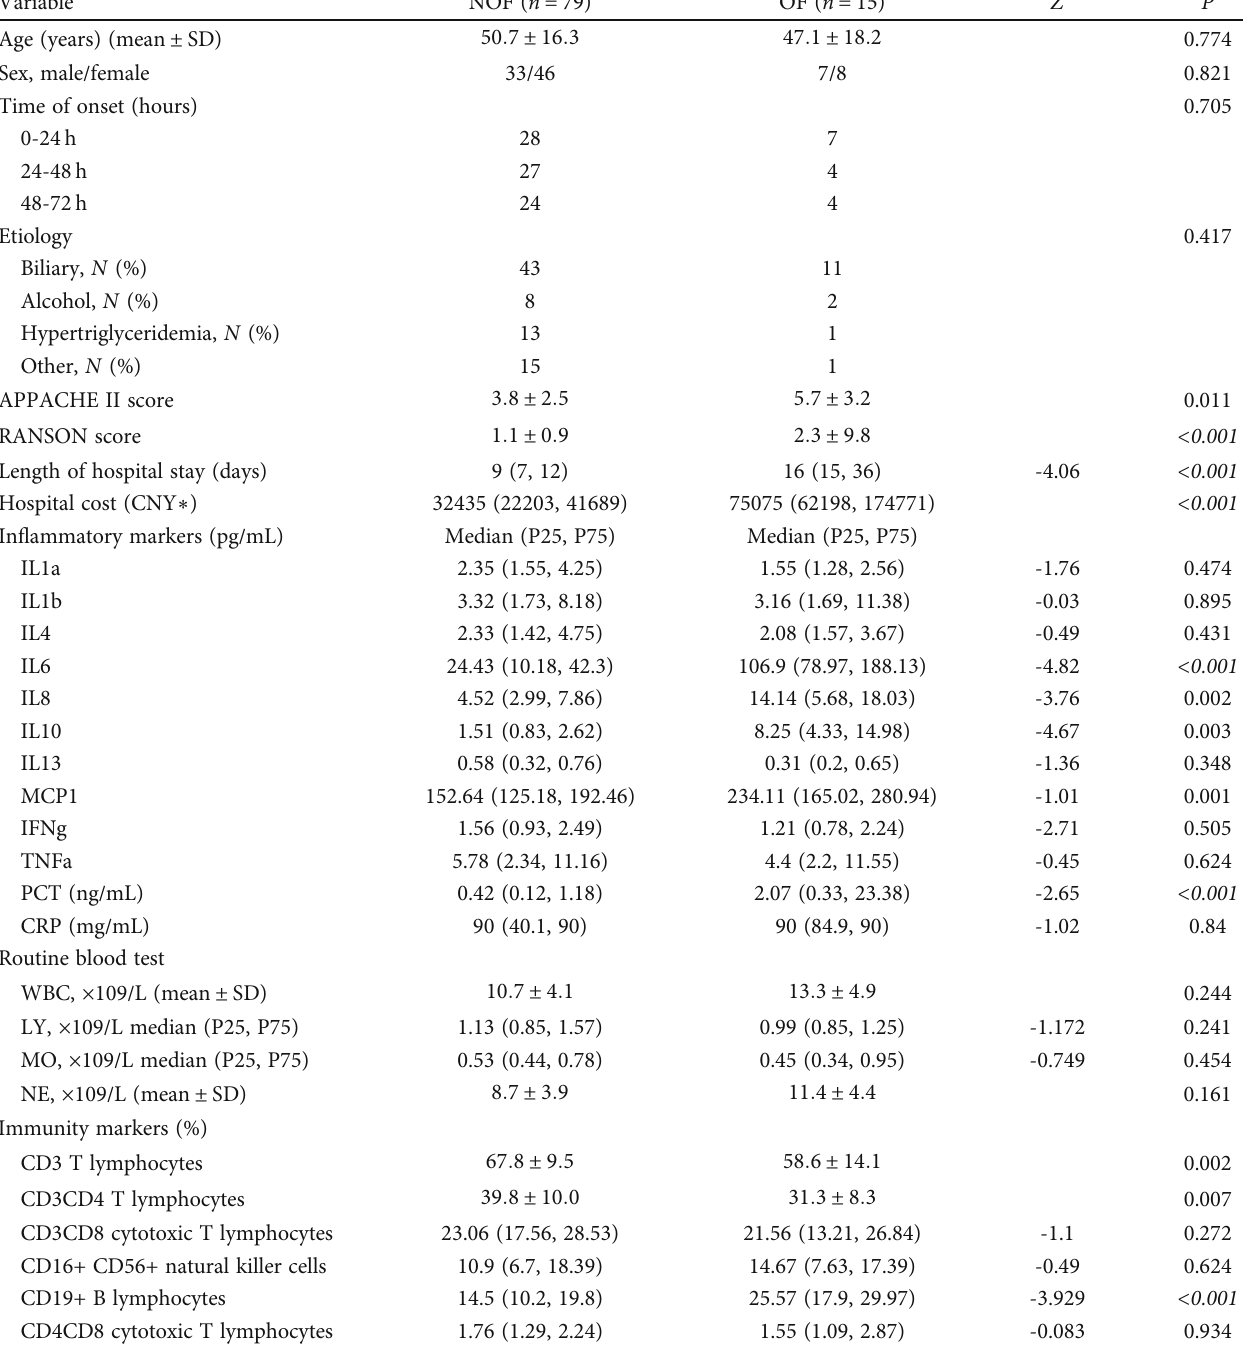
Table 2: Characteristics of enrolled